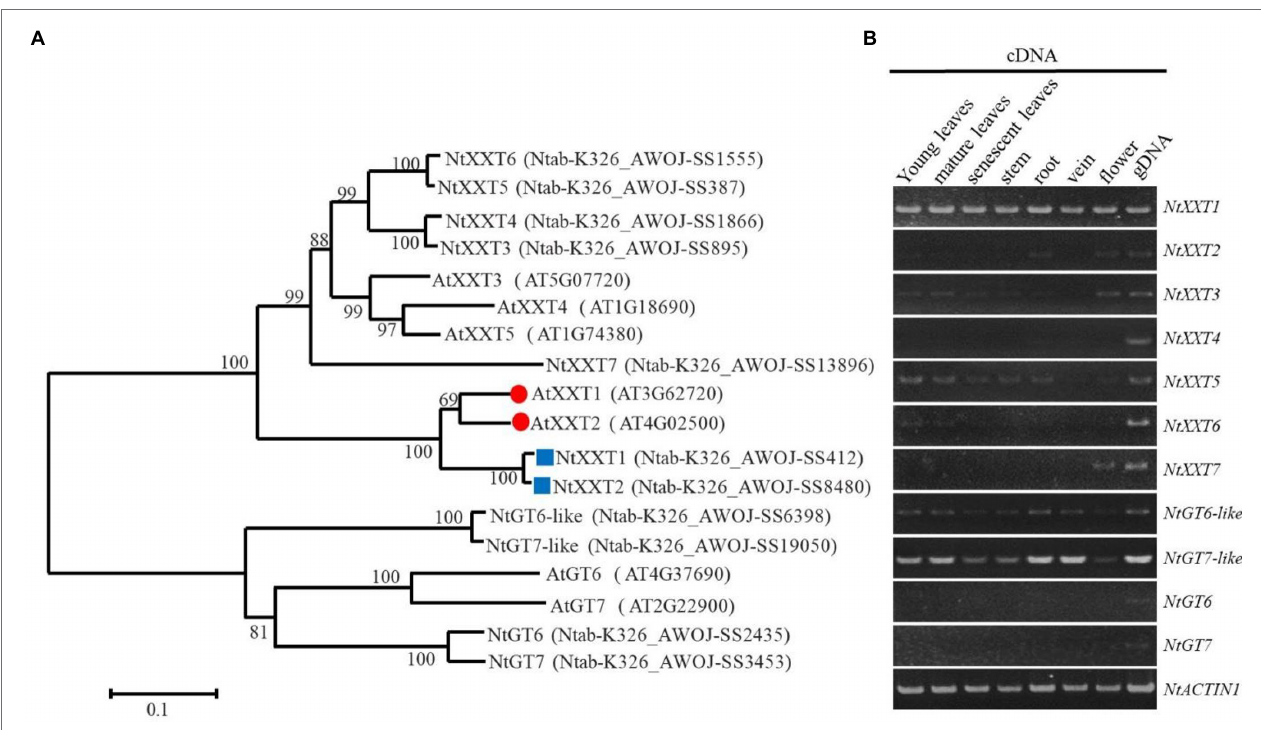
FIGURE 1 | Phylogenetic analysis of NtXXT and AtXXT protein sequences and tissue-specific expression of the corresponding NtXXT genes. (A) Phylogenetic analysis of the AtXXT and NtXXT, NtGT protein sequences. The red circles indicated the genes that been well studied in Arabidopsis . The blue boxes indicated the NtXXTs that are tightly closed to the well-studied AtXXTs. (B) The expression pattern of all the NtXXTs in different stages of leaves, stems, roots, vein, and